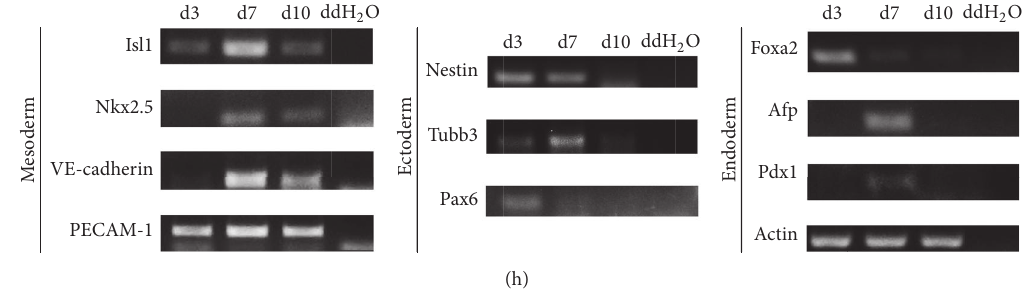
Figure 2: Selection of cells with Pvec activity during differentiation. (a) Schematic representation of selection strategy during differentiation of genetically modified ESCs to isolate Pvec + cells. (b) Optical microscope images of clone A11- and E14T-derived cells, during selection at d4 (before the addition of puromycin), d5, and d10 (selected cells). (c) Quantification of EGFP + cells during clone G11 differentiation/selection at d4.5, d6, d7, and d8 by FACS analysis (representative results are shown). (d) Analysis of FACS data from three independent experiments. ∗∗∗ 𝑃 < 0.001 . (e–g) G11-derived EGFP + selected cells at d7 coexpress VE-cadherin, Isl1, and GATA4. Note that EGFP was detected at low Isl1 and GATA4 expressors. (h) Expression of mesodermal, endodermal, and neuroectodermal markers during selection of clone A11 at d3, d7, and d10 by RT-PCR